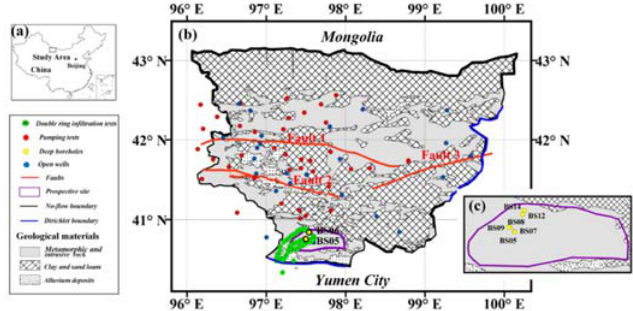
Figure 1. Sketch map of the study area: ( a ) map of China; ( b ) map of the study area; and ( c ) location of boreholes in the prospective site of the disposal repository.